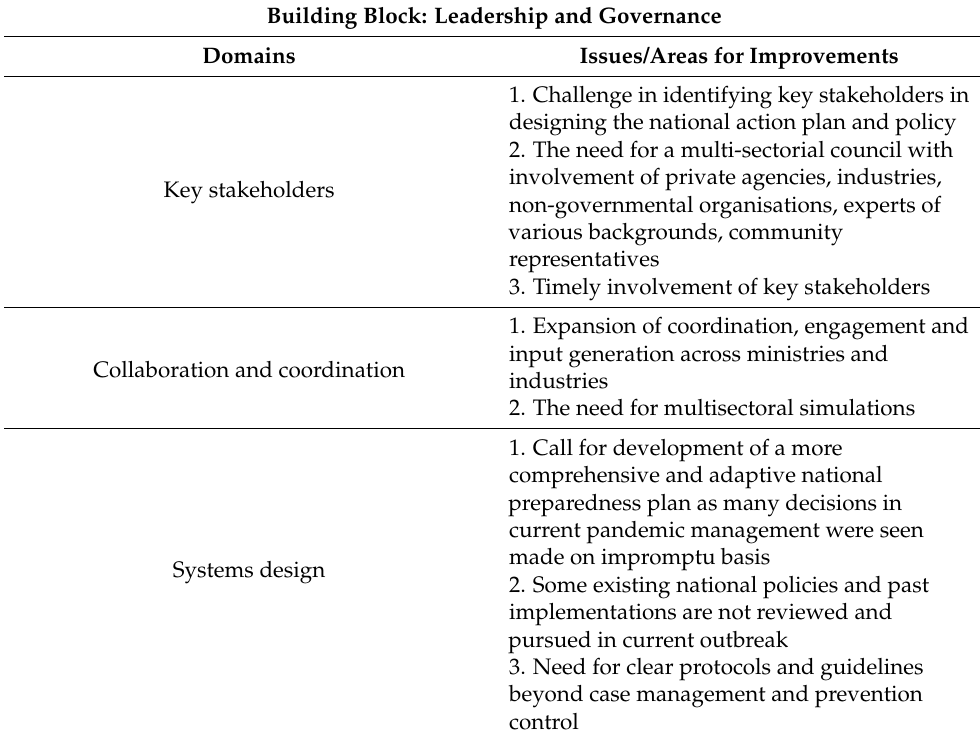
Table 3. Issues of health systems response according to the building